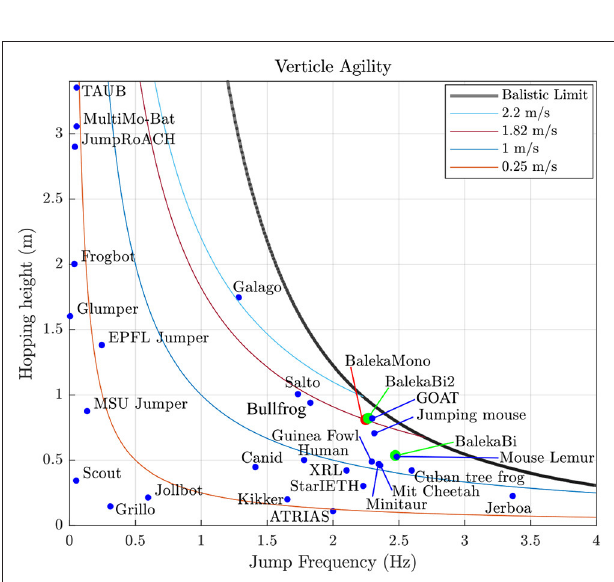
FIGURE 10 | Image comparing the vertical agility of robotic platforms. The ballistic limit is also shown. The performance of Baleka can be seen to out perform the majority of other platforms and lies on the 2.2m/s vertical velocity line.